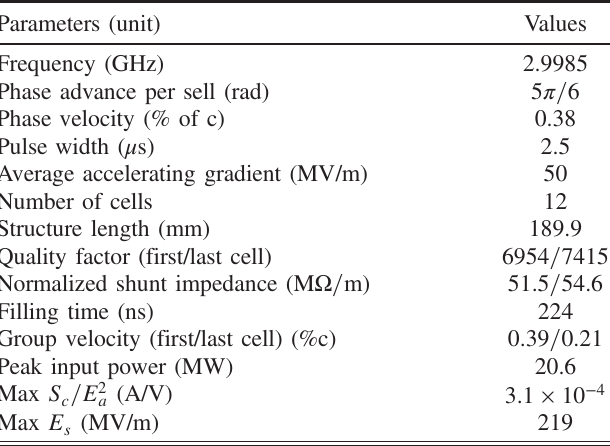
TABLE I. Main parameters of the accelerating